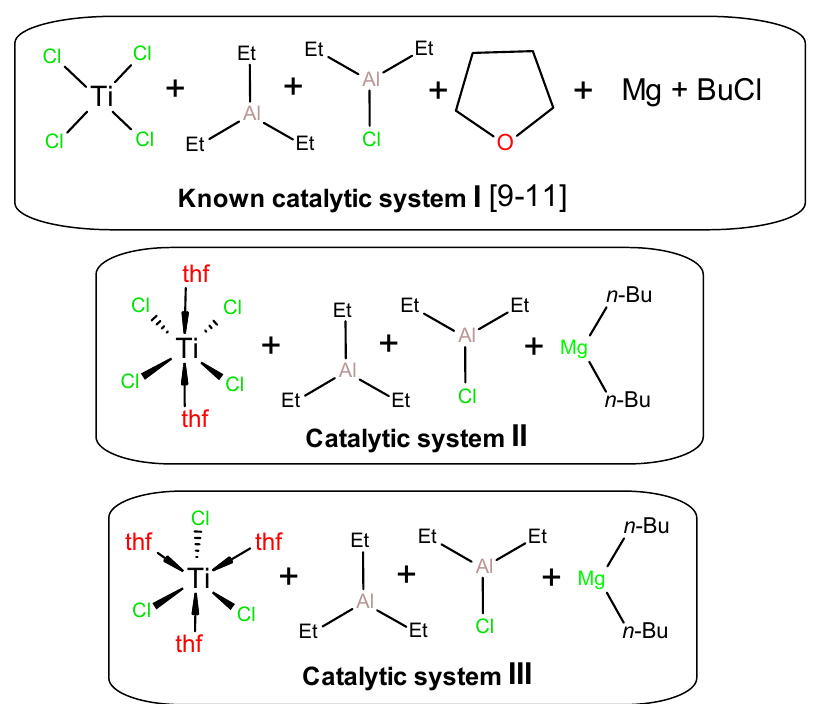
Figure 1. Compositions of catalytic systems I – III used in the present study. The exact ratio of activators for each experiment is given in Table 1.